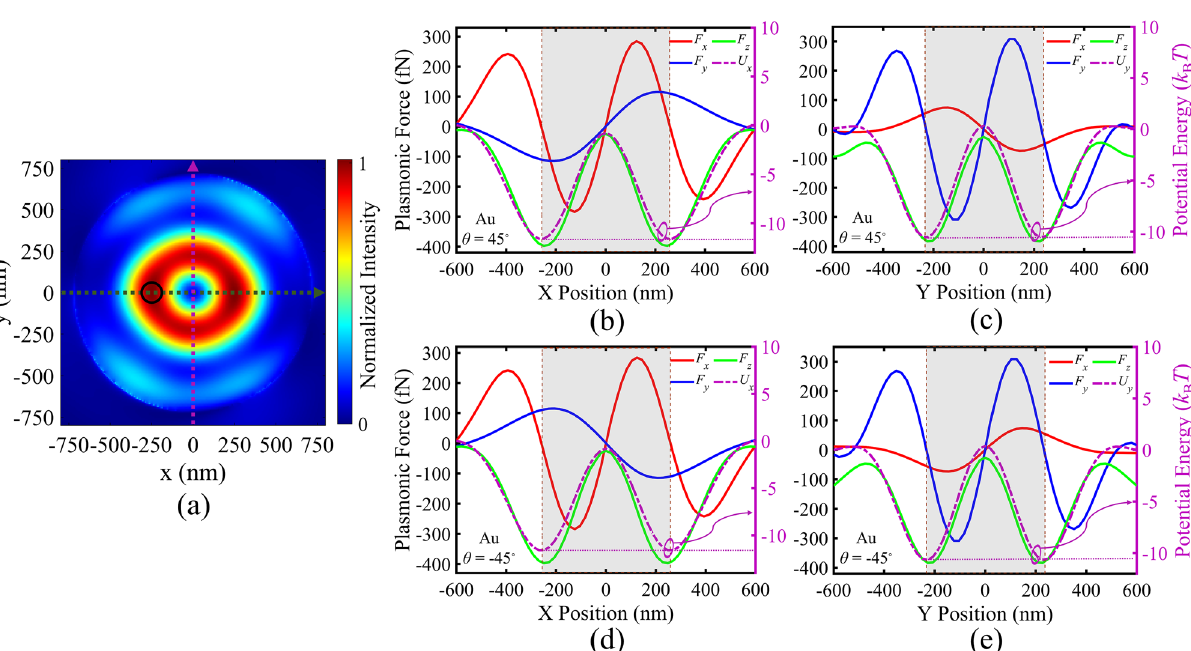
Figure 4. ( a ) Directions of a gold particle movements with respect to the normalized field intensity distribution of generated PV in MIM structure (design I). Plasmonic force analysis for a gold sphere (shown by black circle) with the radius of 60 nm in the PV field: ( b , c ) Calculated plasmonic forces F x , F y , F z and the corresponding potential wells at various x -offsets and y -offsets of the particle center, for θ = 45°, ( d , e ) Calculated plasmonic forces F x , F y , F z and the corresponding potential wells at various x -offsets and y -offsets of the particle center, for θ = −